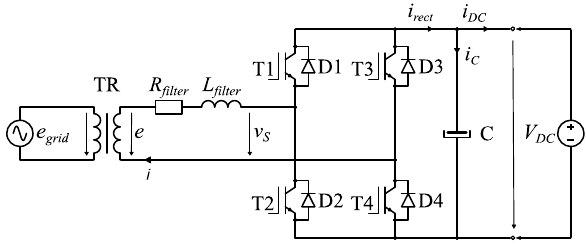
Figure 4. Schematic of single-phase grid-connected bidirectional inverter in the experimental setup.